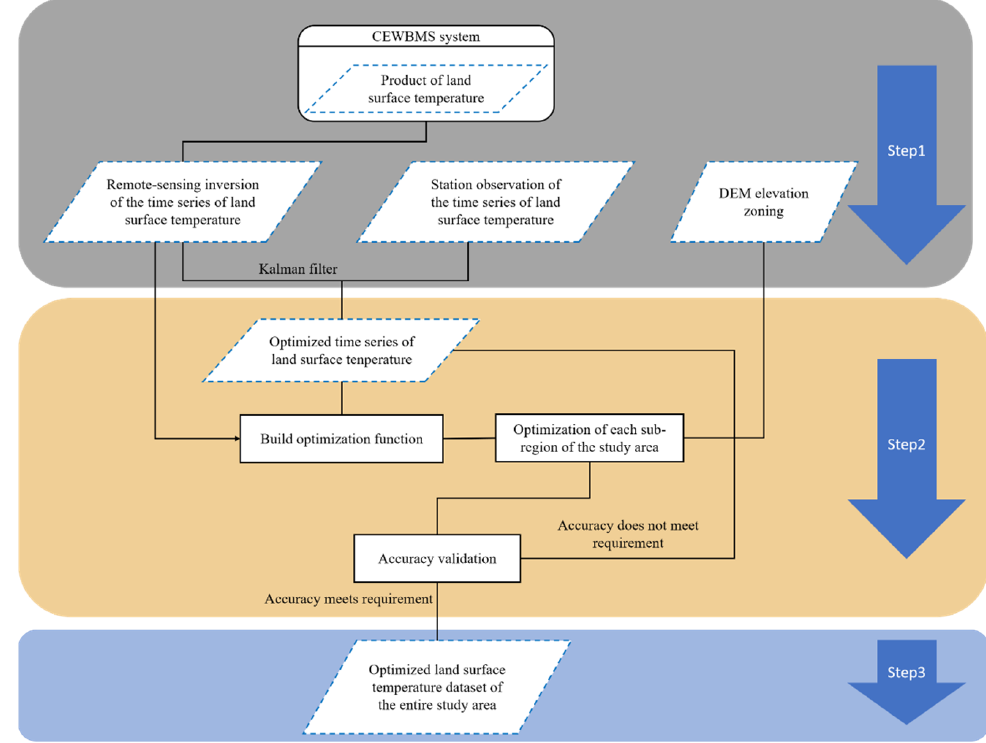
Figure 2. Flowchart of the operation of the